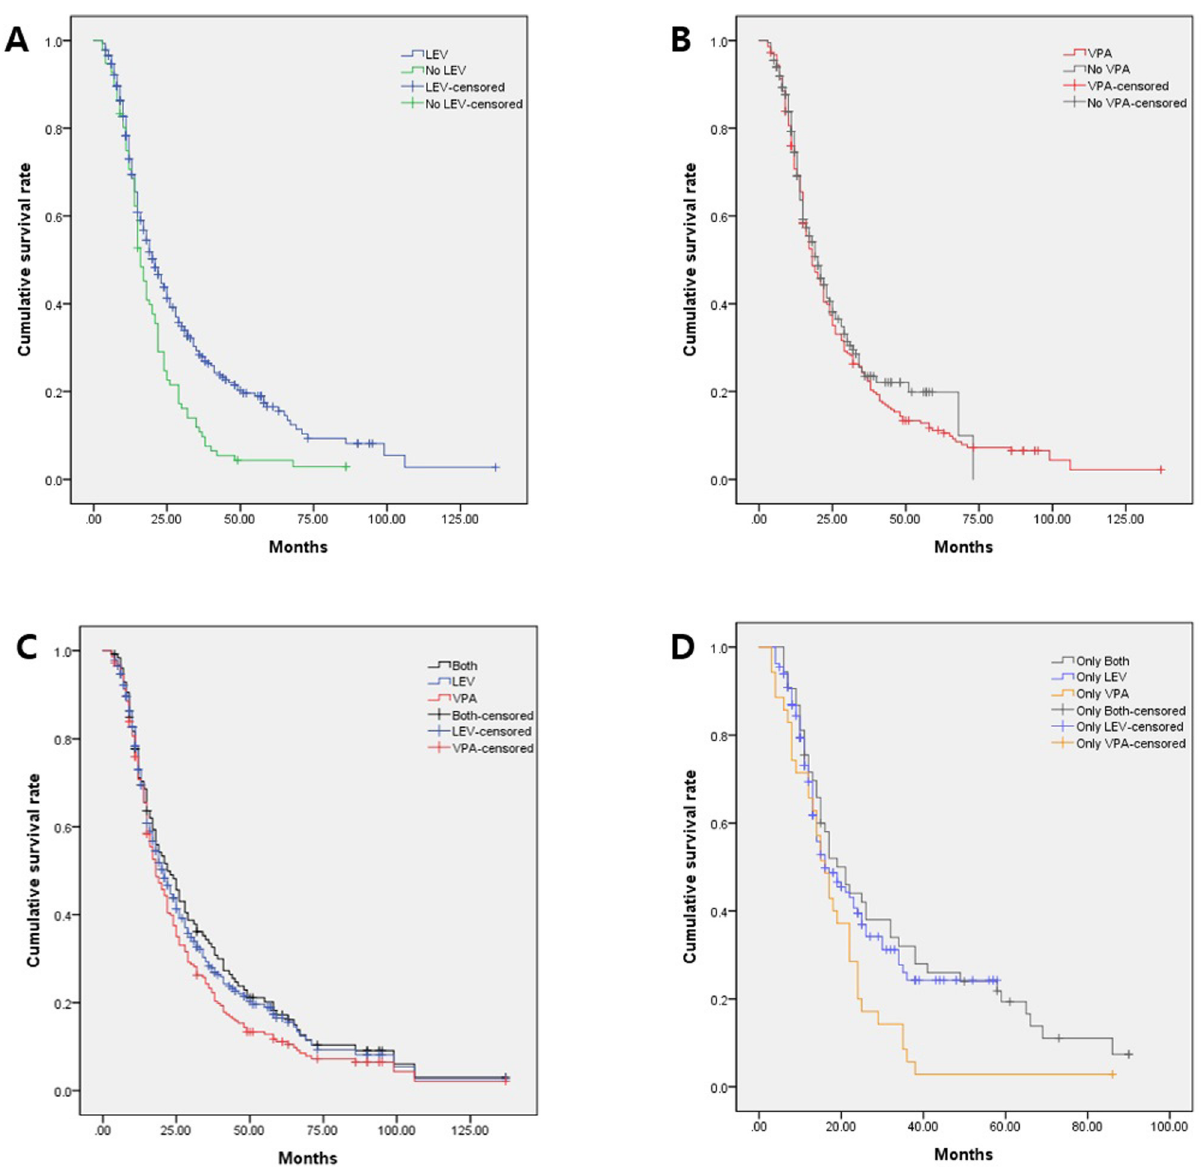
Fig 1. The Cox proportional hazard regression forest plot showing the risk of each antiepileptic drug in patients with glioblastoma. HR, hazard ratio; CI, confidence